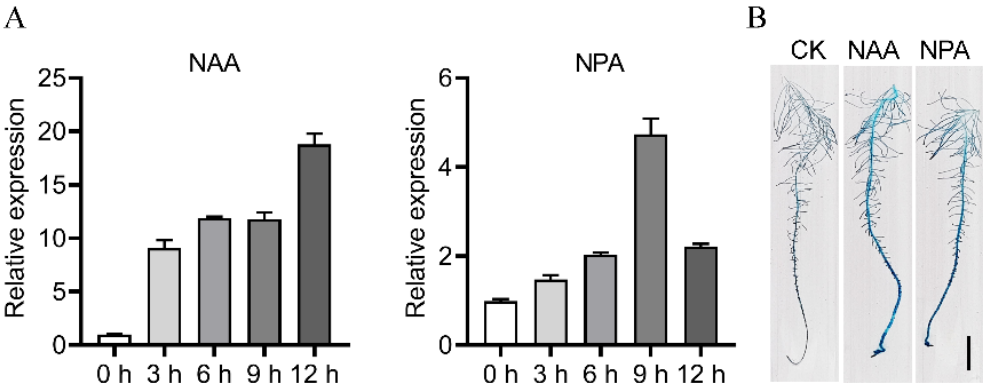
Figure 2. Expression analysis of OsPIN1b response to NAA and NPA treatment. ( A ) qRT-PCR analysis of OsPIN1b expression in rice seedling roots treated with NAA or NPA. ( B ) GUS staining experiment was performed after NAA or NPA treatment for 1 day. Bar = 0.5